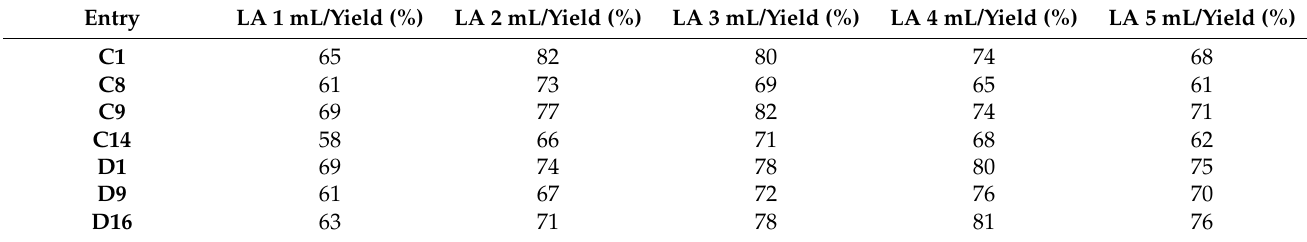
Table 4. Influence of different amounts of lactic acid on the solvothermal synthesis of DHPM derivatives a